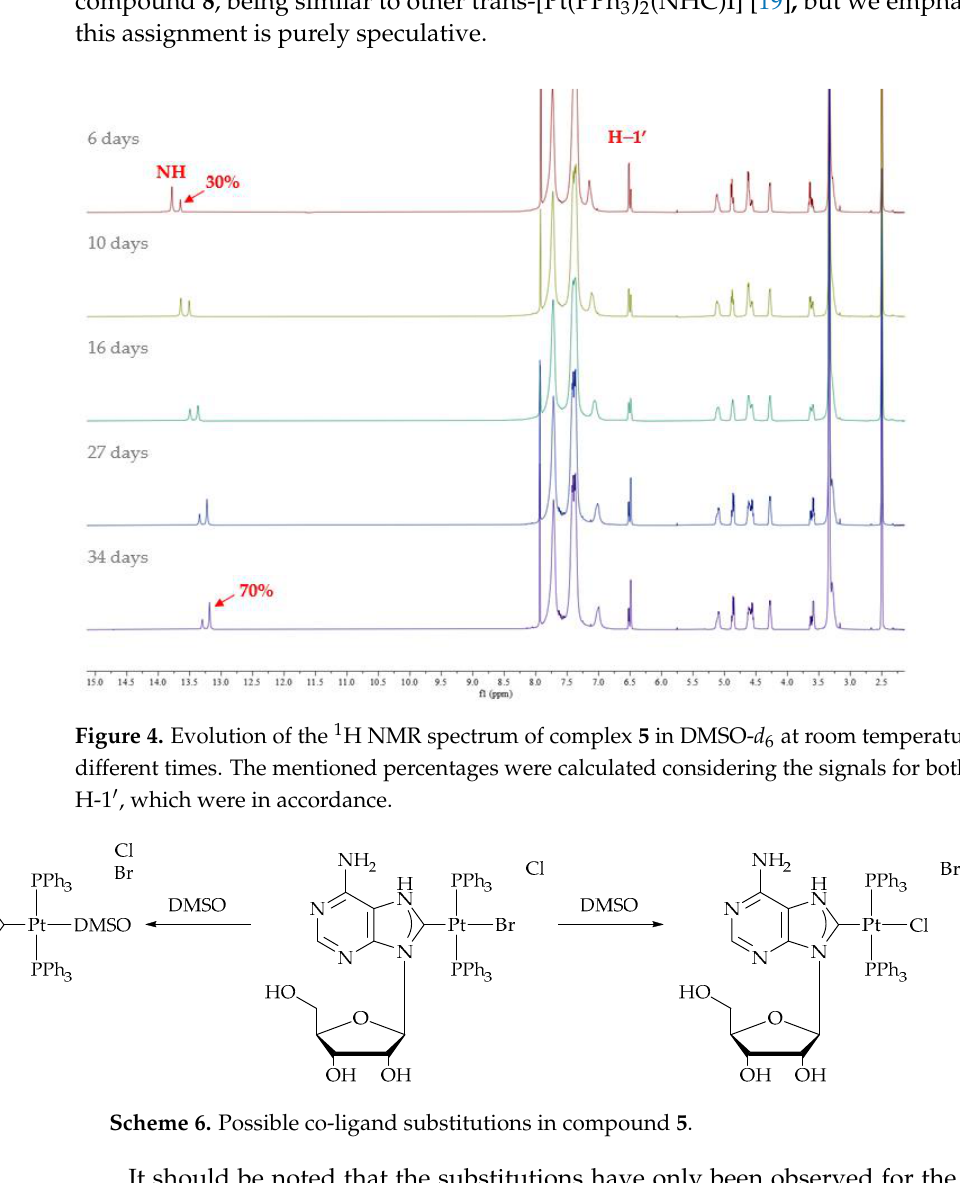
Scheme 6. Possible co-ligand substitutions in compound 5